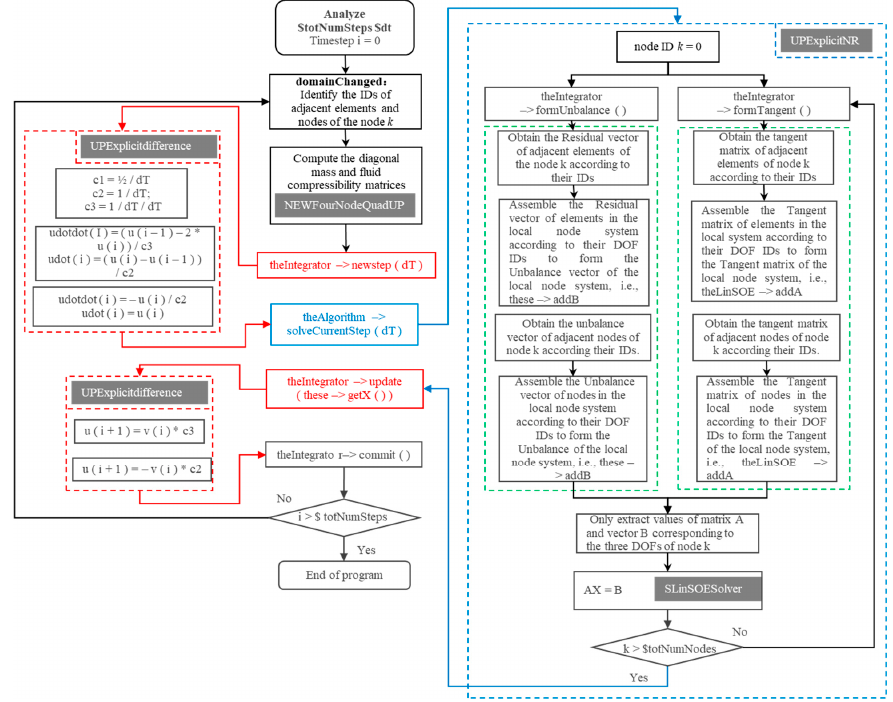
Figure 2. Computational flowchart of the explicit method.